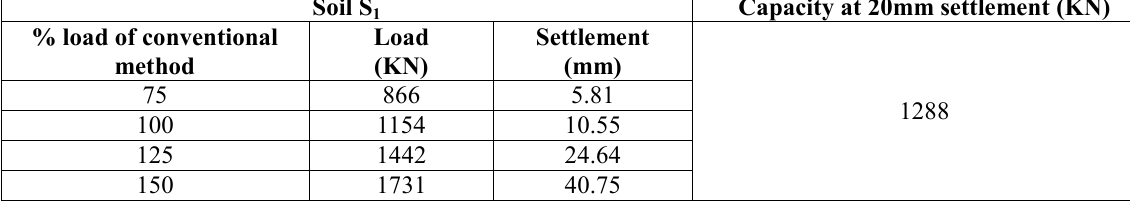
Settlements of D single pile under different loads to find capacity. [Mohr Coulomb 600